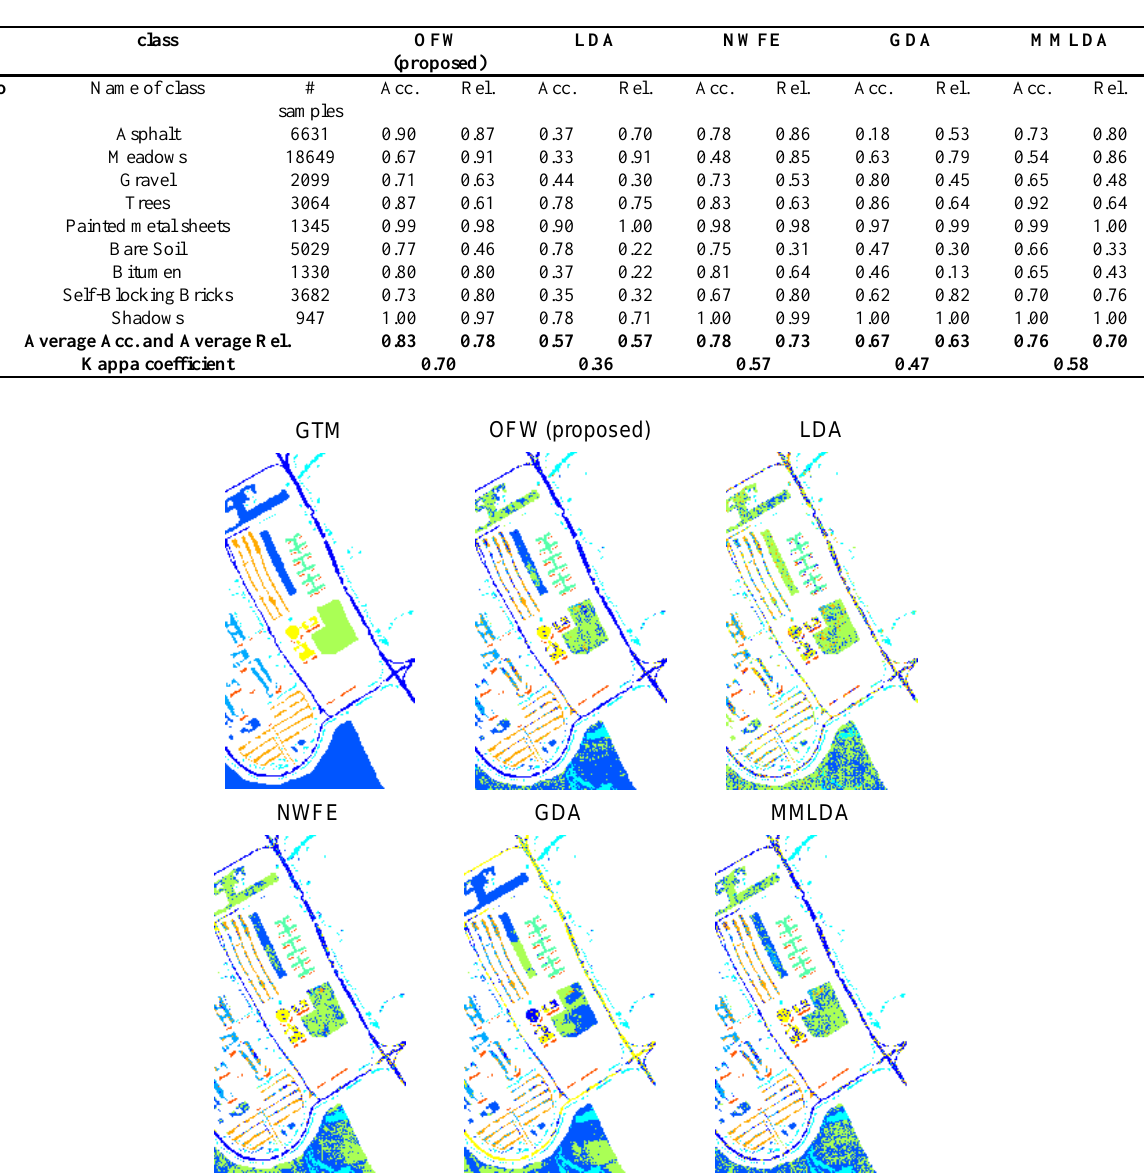
Figure 8. GTM and classification maps for Pavia dataset obtained by SVM classifier and 8 extracted